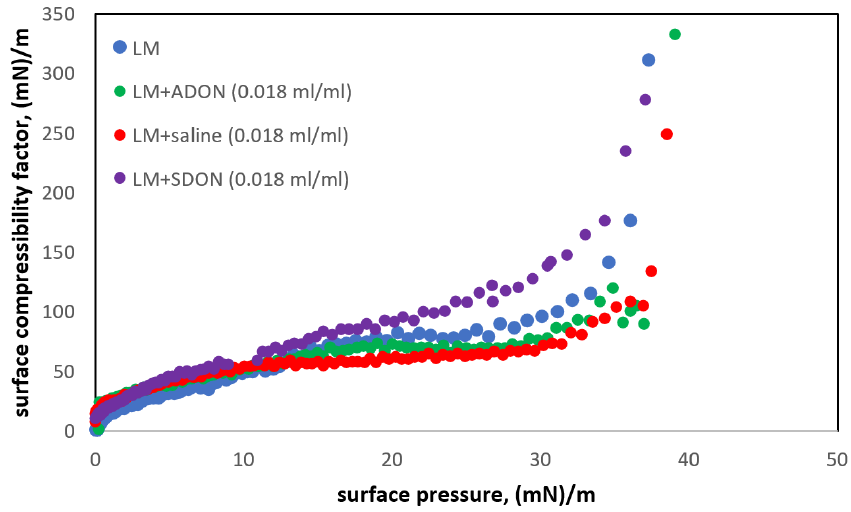
Figure 3. Isothermal surface compressibility factor of LM monolayer on the aqueous subphase in the presence of ADON or